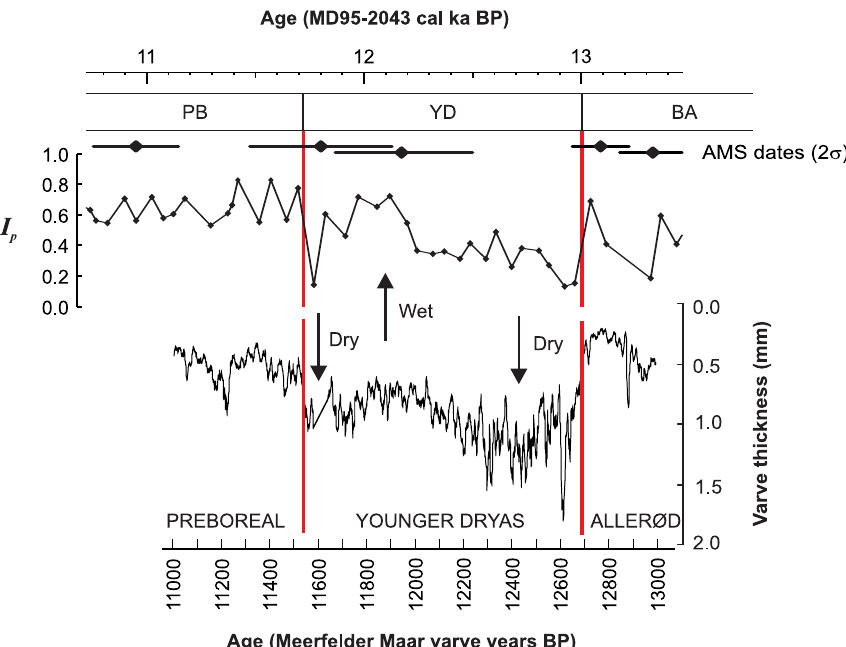
Fig. 6. Comparison of the MD95-2043 pollen-based precipitation index ( I p ) and Meerfelder Maar varve thickness record (Brauer et al., 1999) for the Younger Dryas interval. Note: the records are plotted on independent timescales and have been aligned visually with respect to the onset and end of the YD (red bars). Similarities in the records suggest parallel hydrological changes between Northern Europe and the Western Mediterranean, with dry conditions (lower I p values) in MD95-2043 associated with increased varve thicknesses and sedimentological indications (Brauer et al., 1999) of dry conditions at Meerfelder